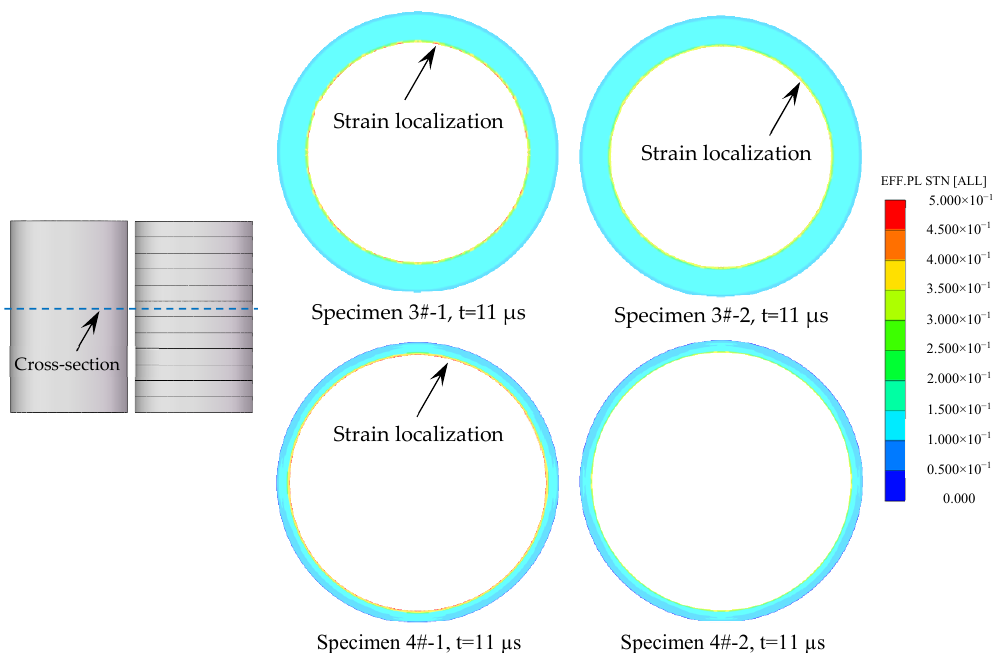
Figure 17. The e ff ective plastic strain of the representative cross-section of the Figure 17. The effective plastic strain of the representative cross-section of the specimens.